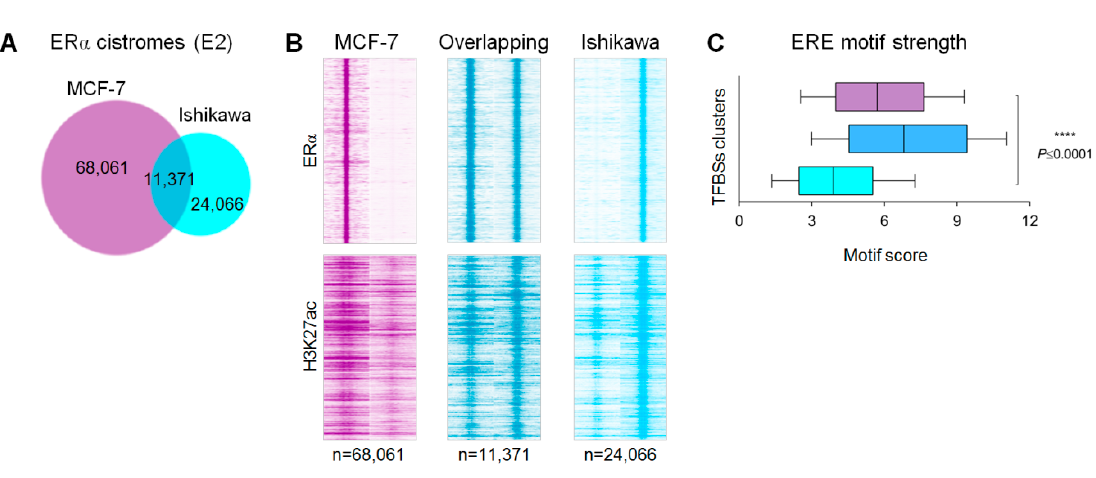
Figure 1. Genome-wide comparison of ER α cistromes and transcriptomes in MCF-7 and Ishikawa cells upon E2 treatment. (A) Area-proportional Venn diagram showing the overlap between all ER α TFBSs upon E2 treatment in MCF-7 and Ishikawa cells. (B) Read distribution plots showing the presence or absence of the identified cell line-specific and overlapping ER α TFBSs and the H3K27ac signals in 2-kb frames. (C) Box plots showing the ERE motif strength within the summit ±100-bp region of the shared and cell line-specific TFBSs, defined in Figure 1A. The boxes represent the first and third quartiles, the lines indicate the median scores and the whiskers indicate the 10th to 90th percentile ranges. Unpaired t-test, **** significant at p <0.0001.